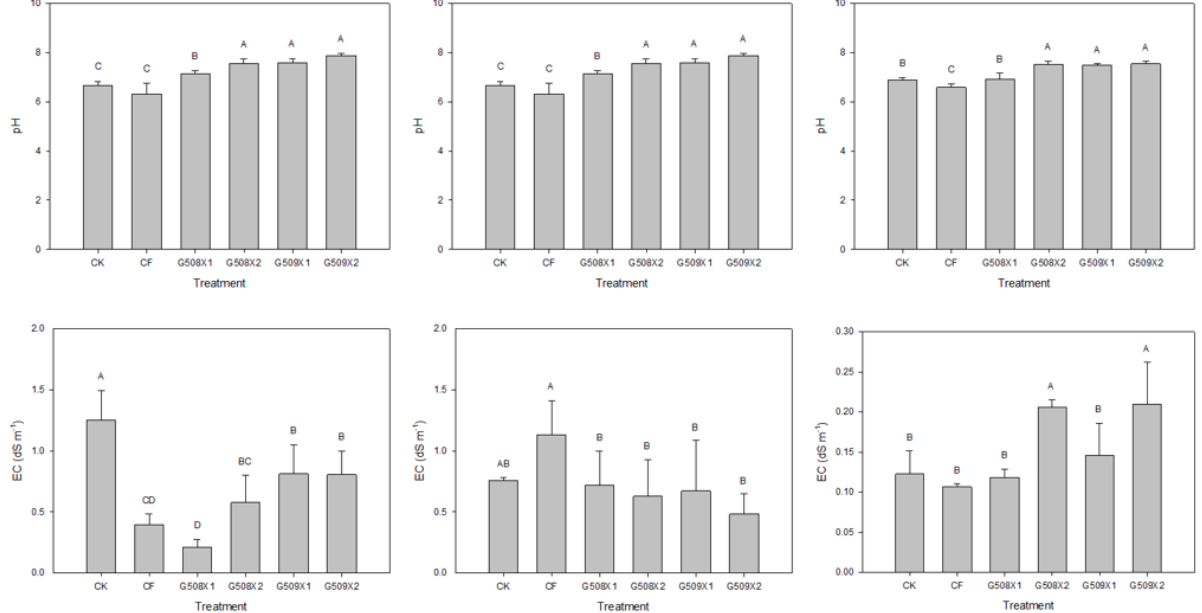
Figure 1. The pH and EC values of the soils after the field experiment: cabbage (left), Chinese cabbage (middle), and water spinach (right). The different letters indicate the significance among the treatments obtained through one-way ANOVA analysis (Duncan test, p < 0.05, n = 4). CK (control): no amendment; CF: chemical fertilizer at the recommended dose (RDs) of nitrogen; G508X1: G508 at the RD of nitrogen; G508X2: G508 at two times the RD of nitrogen; G509X1: G509 at the RD of nitrogen; G509X2: G509 at two times the RD of nitrogen.